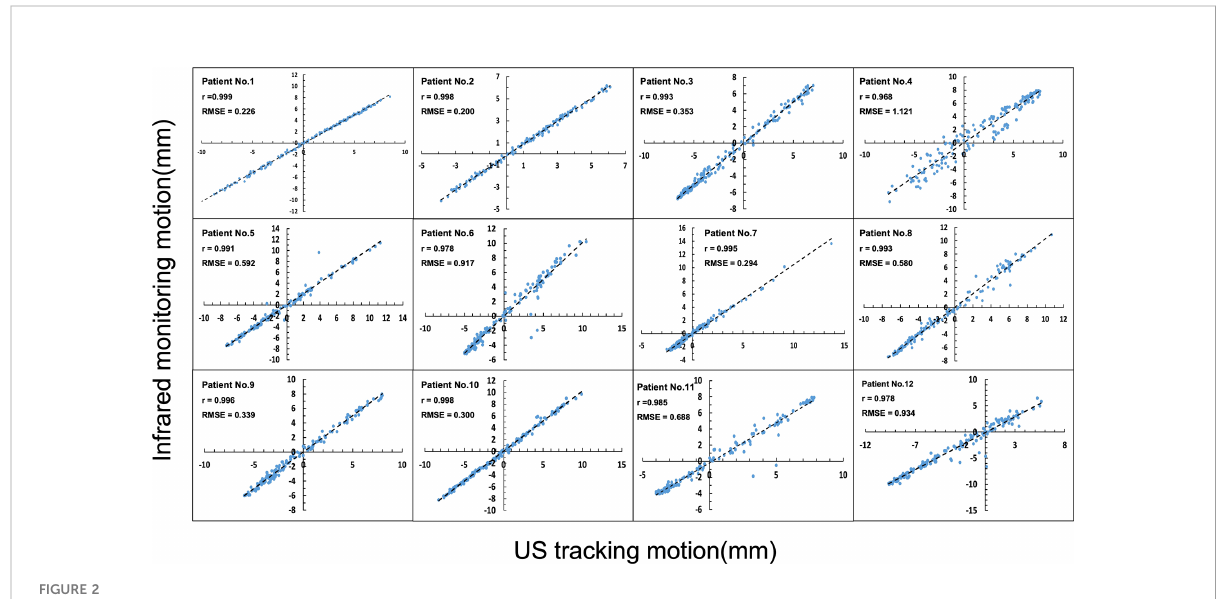
FIGURE 2 Comparison of infrared monitoring motion and ultrasound tracking